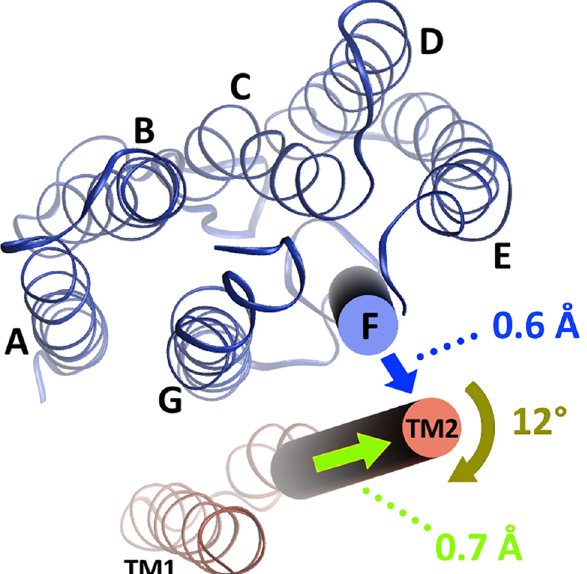
Fig 4. Comparison of the conformational changes of the transmembrane region upon demethylation and illumination. Cytoplasmic view of a monomer of the Np SRII/ Np HtrII complex with experimentally observed conformational changes upon illumination shown as arrows and corresponding numerical values from the CG MD simulations. An outward tilt of helix F at the cytoplasmic side of the membrane embedded part of the transducer by 0.6 ± 0.3 Å (blue arrow) is accompanied by a rotation of helix TM2 of 12 ± 8° (olive green arrow) with respect to the equilibrated methylated structure. In addition TM2 shifts with respect to the helix TM1 of the transducer by 0.7 ± 0.5 Å (light green